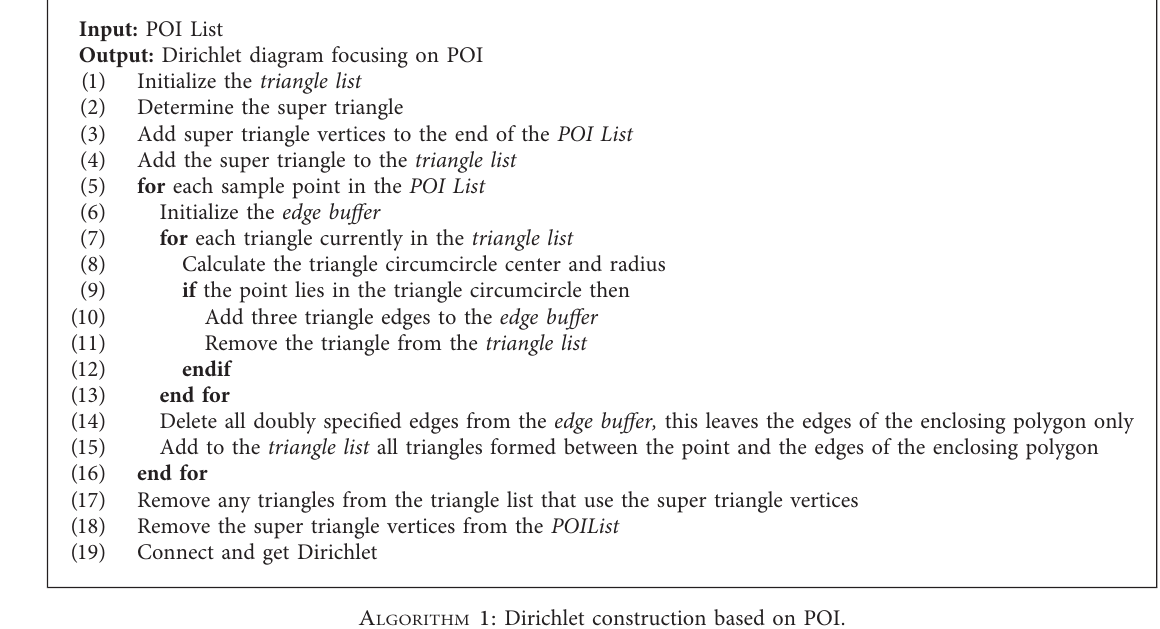
A LGORITHM 1: Dirichlet construction based on